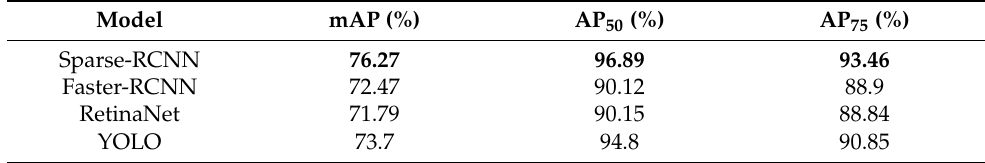
Table 5. The comparison of four models on the vehicle detection